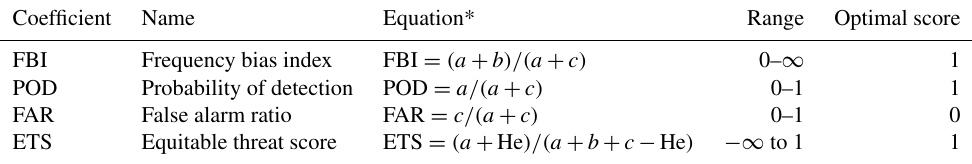
Table 2. Summary of rain event detection